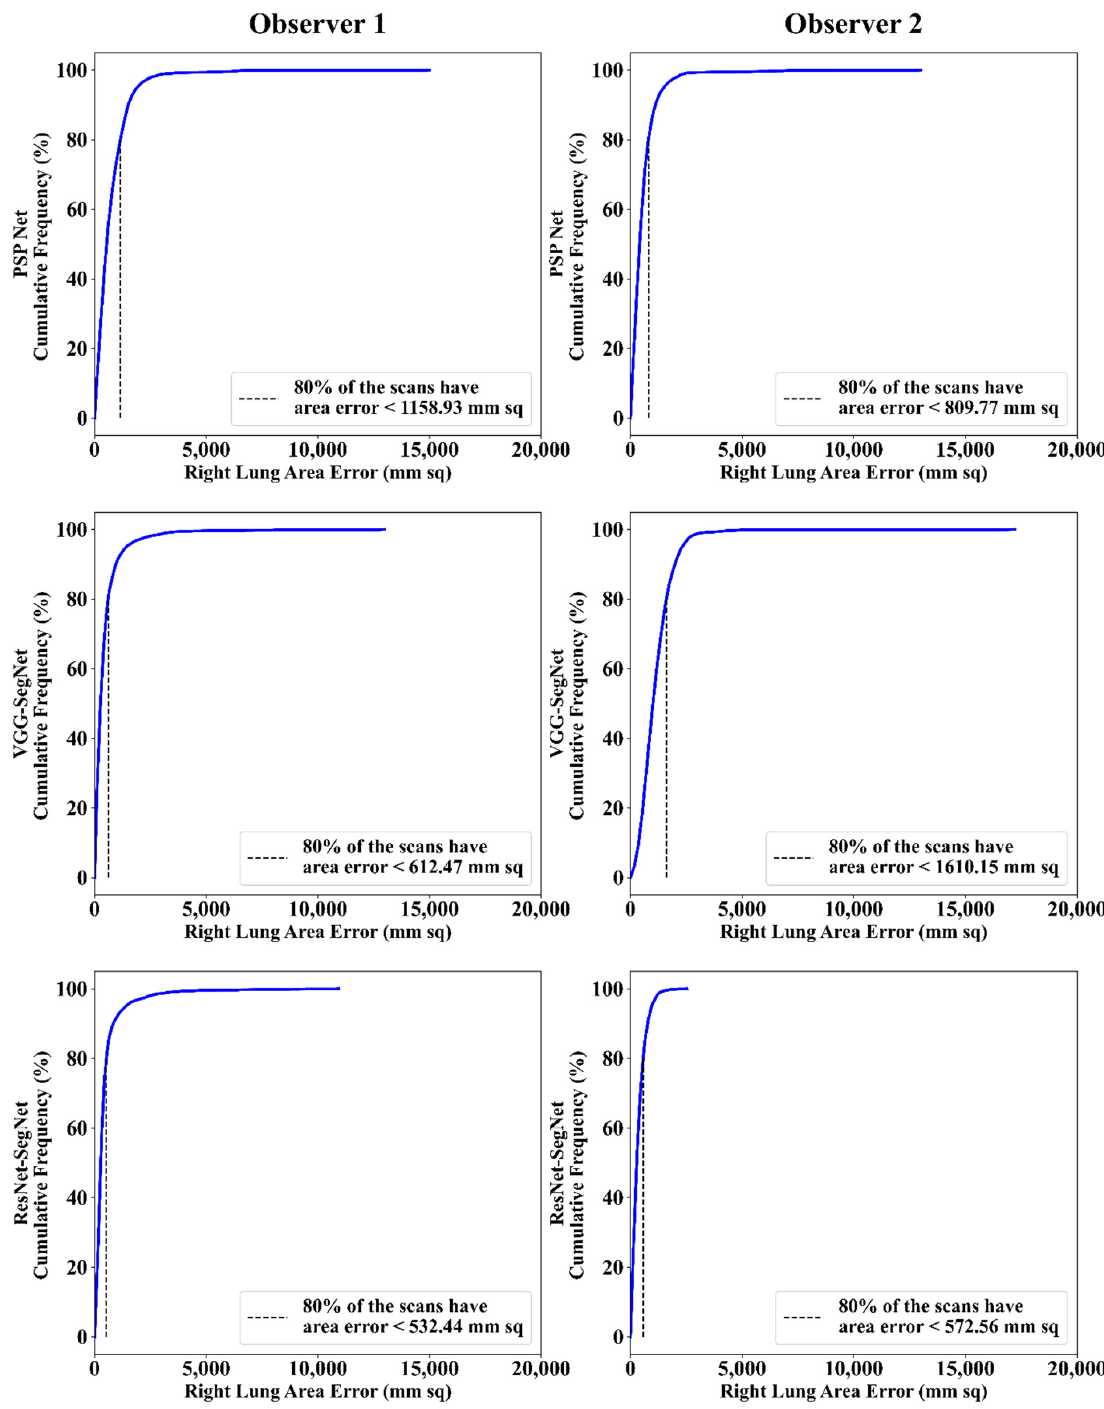
Figure 13. Cumulative frequency plot of right LAE using three AI models: Observer 1 vs. Observer 2. Correlation Plot for Lung Area Error Coefficient of correlations (CC) plots for the three AI models’ LA vs. GT, area corre- sponding to the left and right between Observers 1 and 2, are shown in Figures 14 and 15. The CC values are summarized in Table 1 with a percentage difference between Observers 1 and 2. The percentage difference for the CC value ( p < 0.001) ranges from 0% to 2.04%, which is <5% as part of the error threshold chosen as the hypothesis. This clearly shows that the